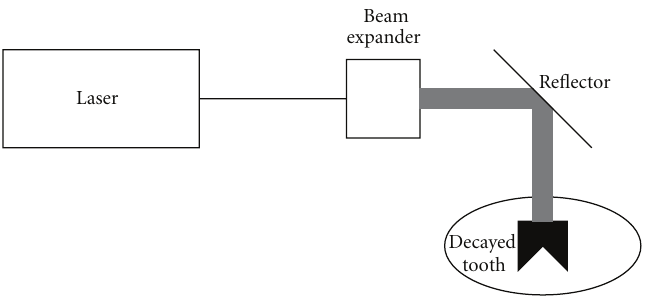
Figure 1: The sketch of quasicontinuous laser system.